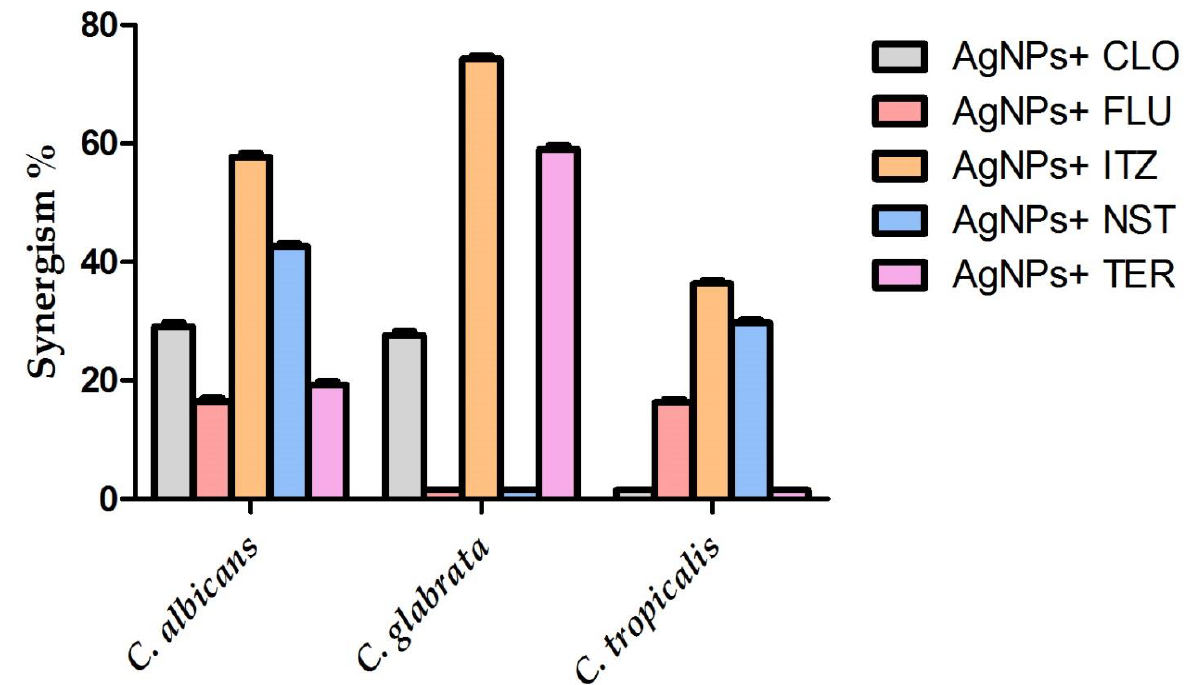
Figure 13. Synergistic percentages (%) of the biogenic silver nanoparticles with common antifungal drugs.